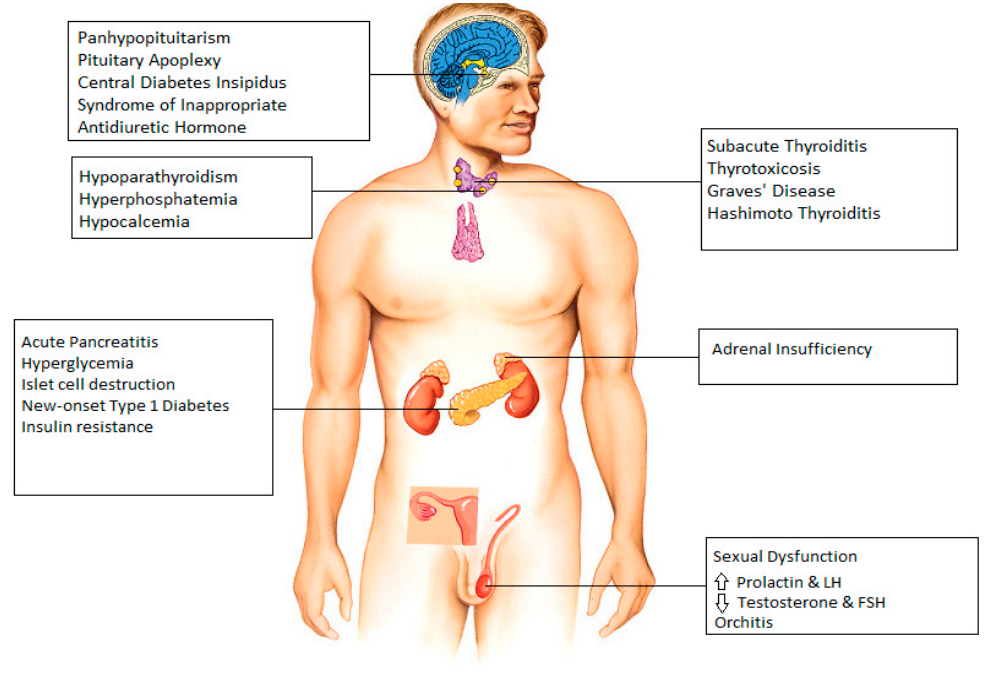
Figure 1. Endocrine manifestations seen after infection with